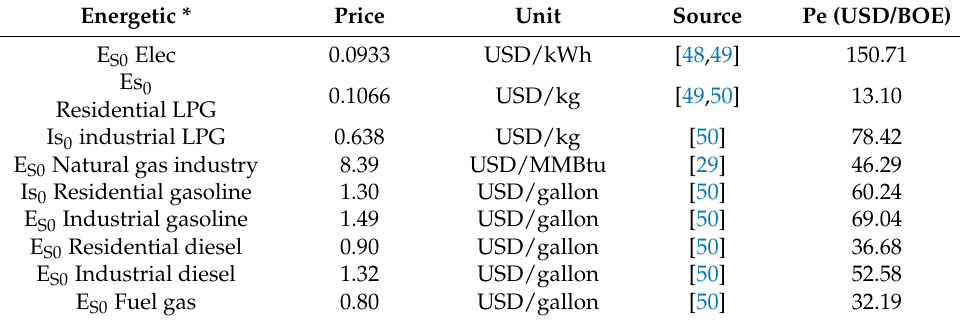
Table 20. Energy prices in Ecuador.